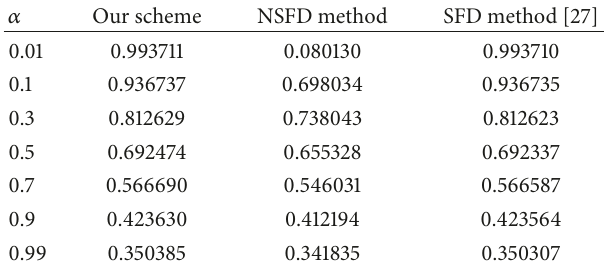
Table 4: Error norm 𝐿 ∞ for Example 5.